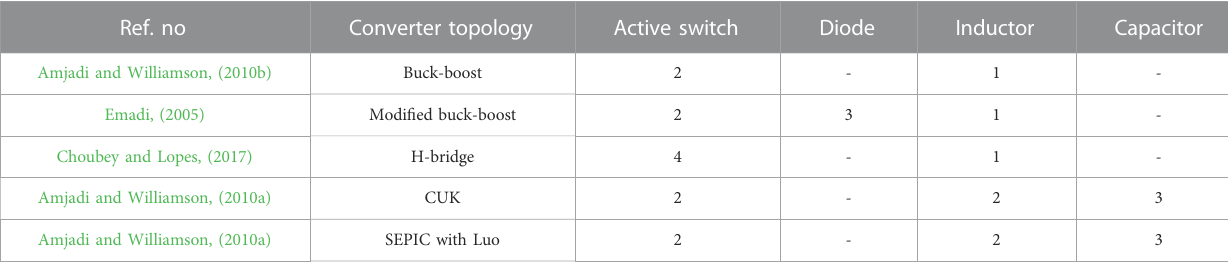
TABLE 3 Elements in non-isolated single-input